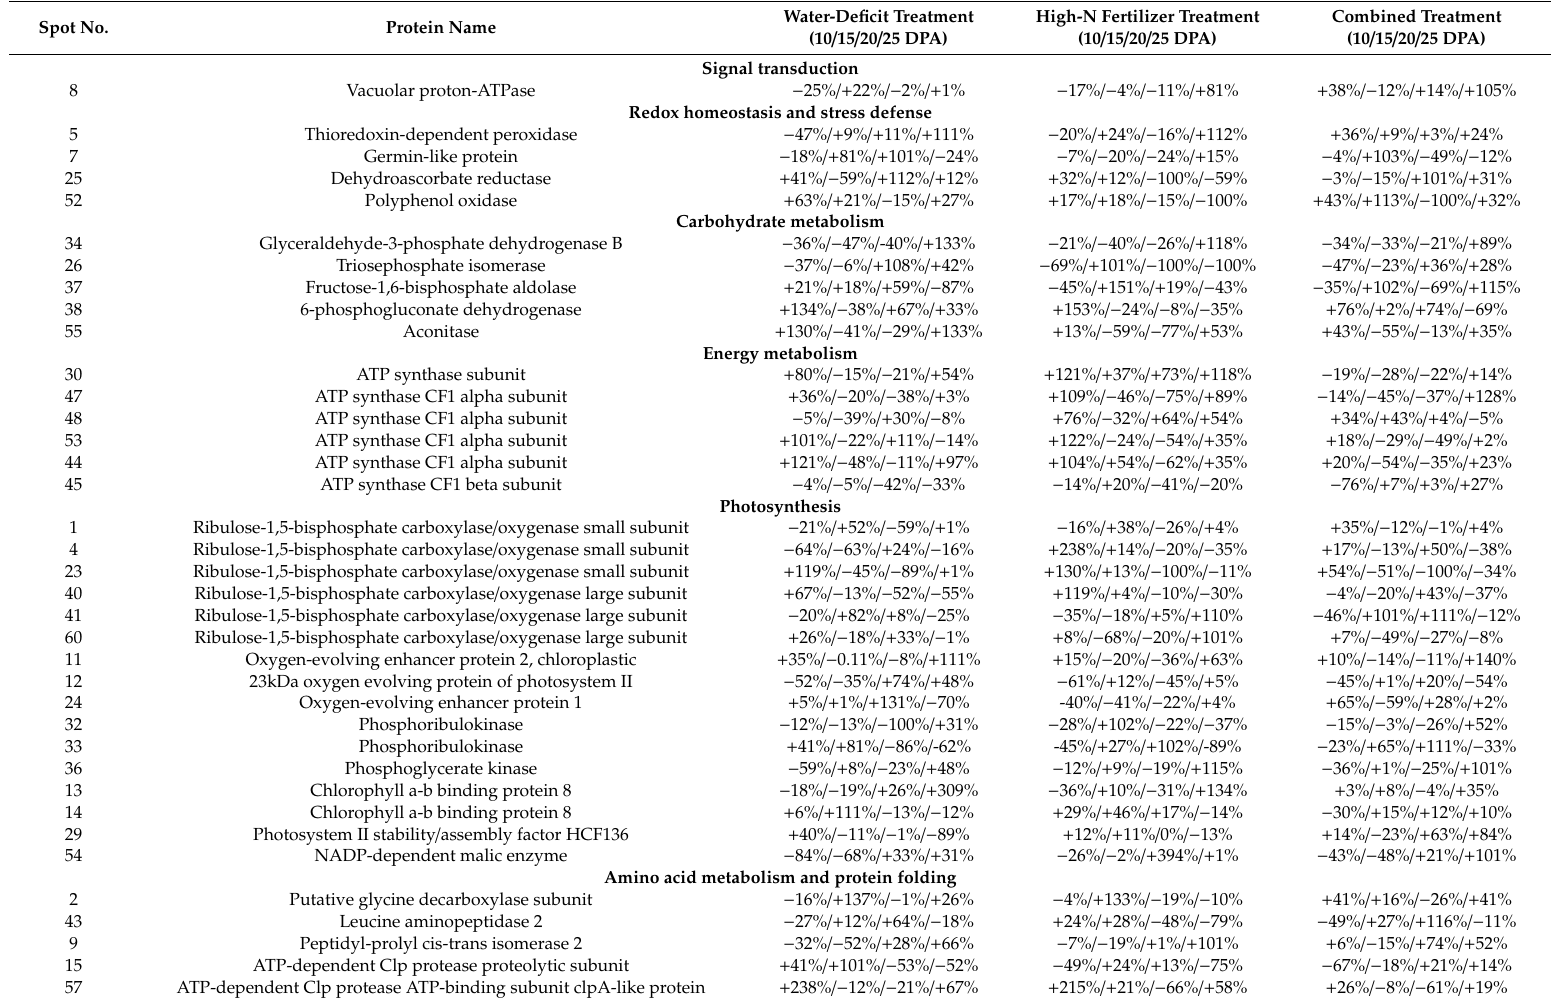
Table 1. The representative DAPs of wheat flag leaves identified by MALDI-TOF / TOF-MS under water-deficit (WD), high-N fertilizer and combined (CB) treatments. Spot